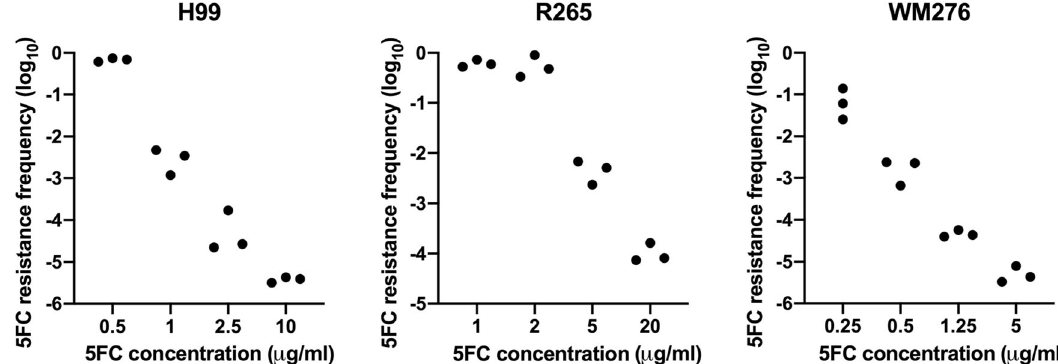
Fig. 1 The frequency of 5-FC resistance varies according to 5-FC concentrations. Cells from H99, R265, and WM276 were plated on YNB media supplemented with indicated amounts of 5-FC which were approximately corresponding to 20-, 40-, 100-, and 400-fold of 5-FC MIC of each tested strain. Plates were incubated at 30 °C for 7 days and photographed. The frequency of 5-FC resistance was calculated by dividing the number of the 5-FC resistant colonies by the total number of the input cells. The experiments were repeated three